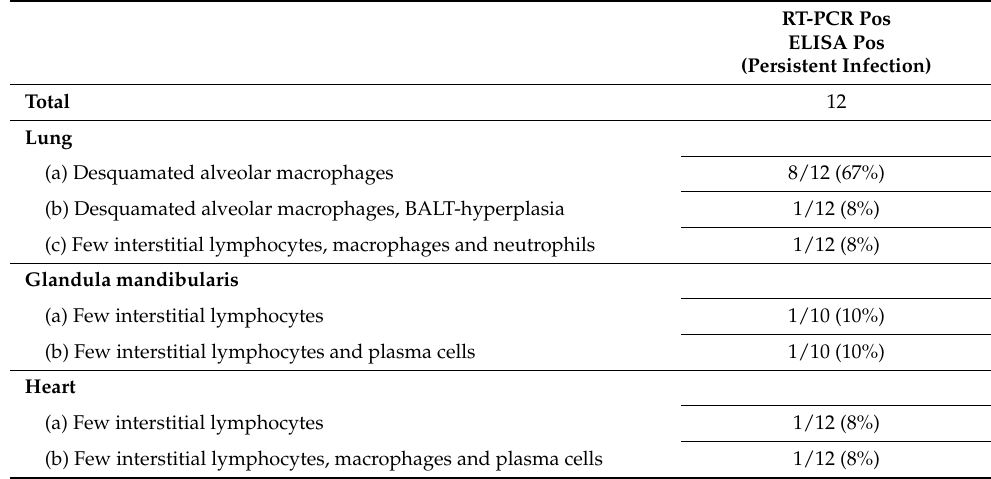
Table 6. Histologic findings in bank voles from BF.